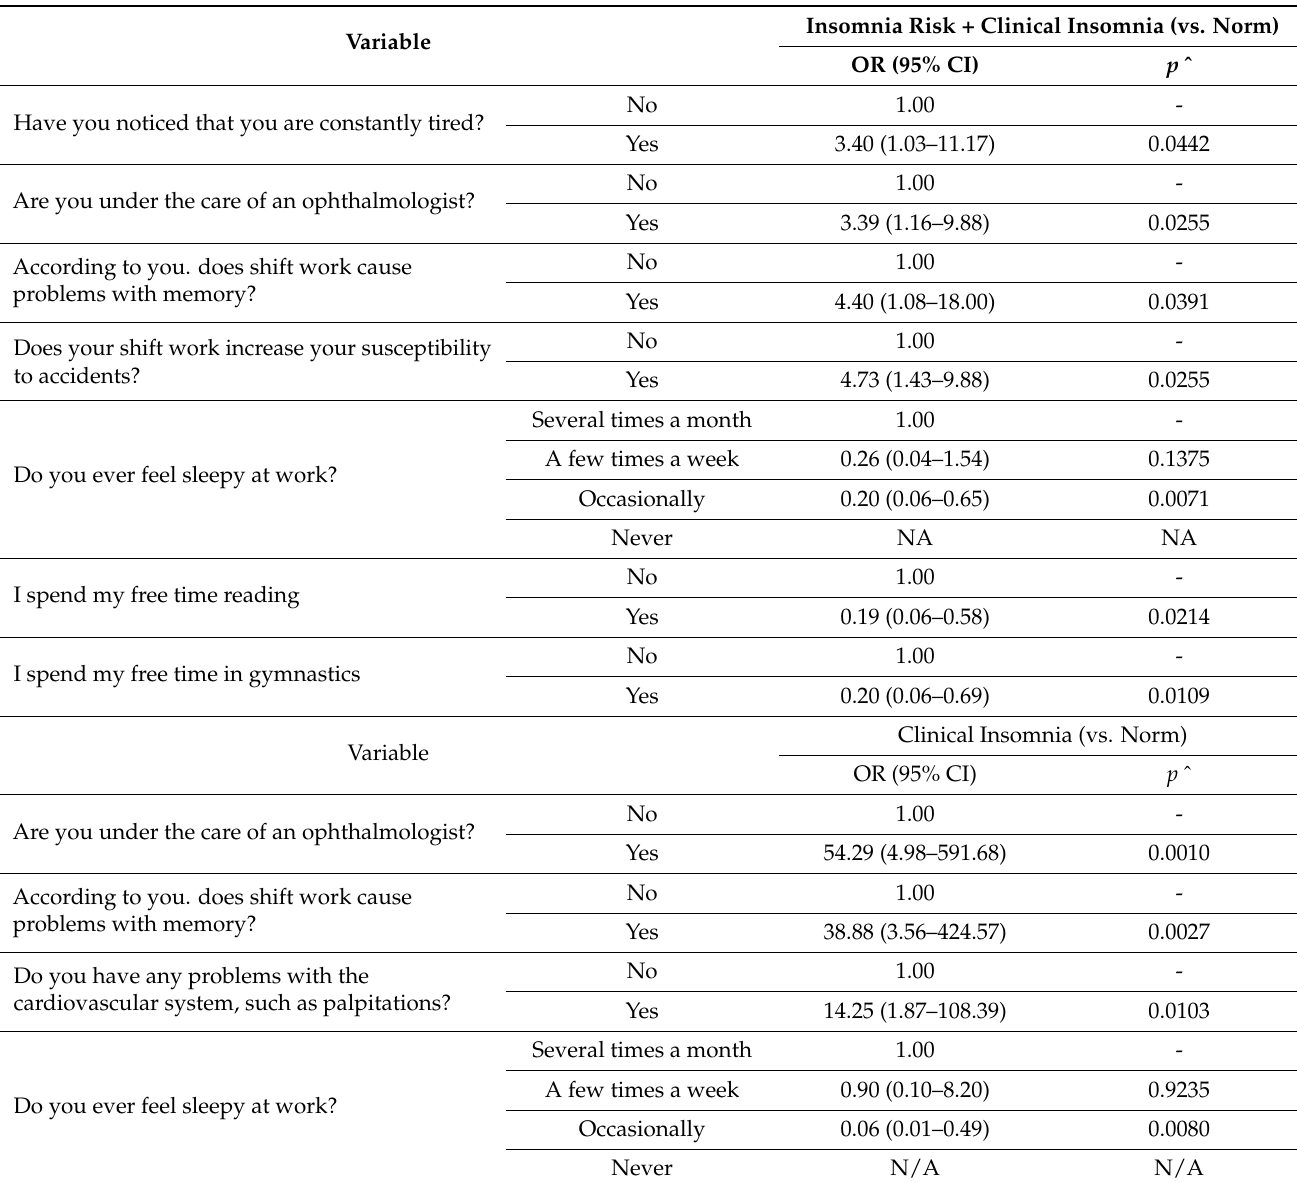
Table 14. Results of multivariate logistic regression carried out among all